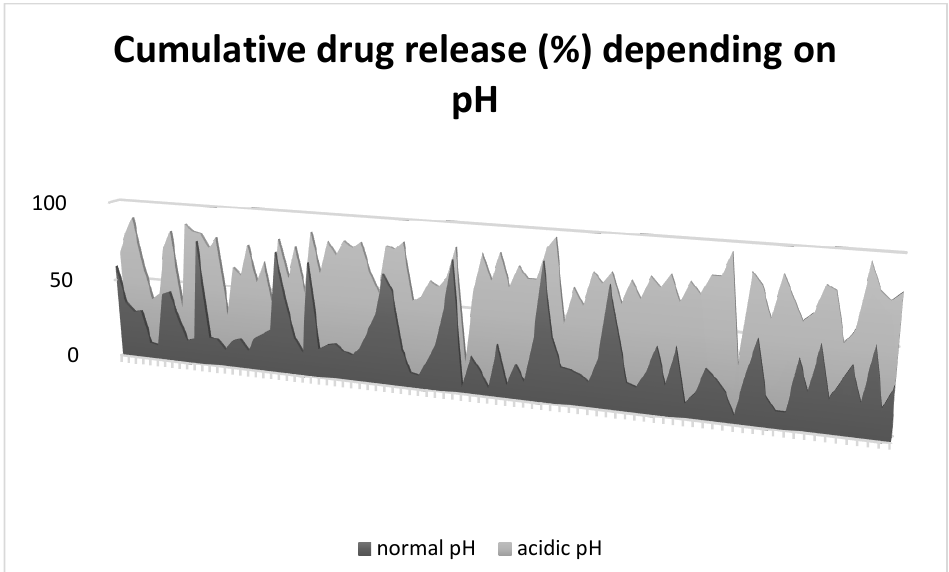
Figure 3. Rate of cumulative drug release for each of the included studies. Dark gray area shows rate (%) of drug released at a physiological pH (7.4). Light gray shows rate (%) of drug released in acidic pH (lowest value used in each study).